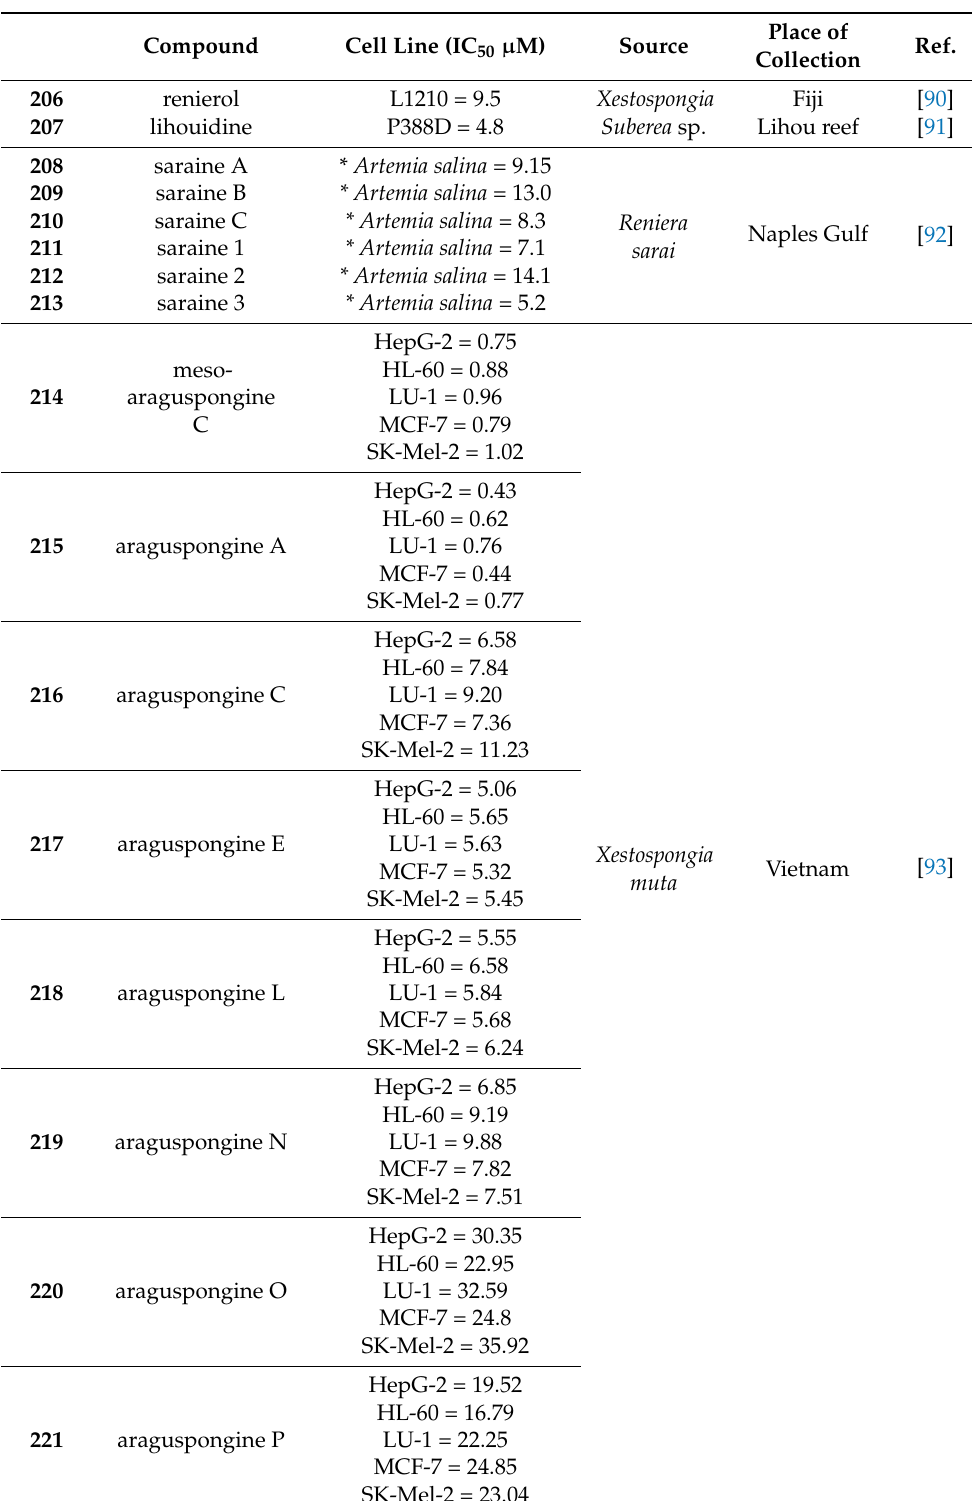
Table 15. Cytotoxic activity of quinoline and quinolizidine